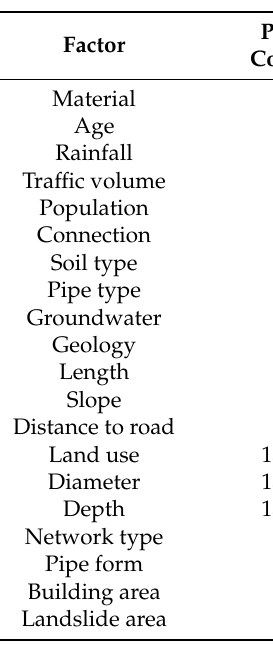
Table 3. Summary of feature selection.